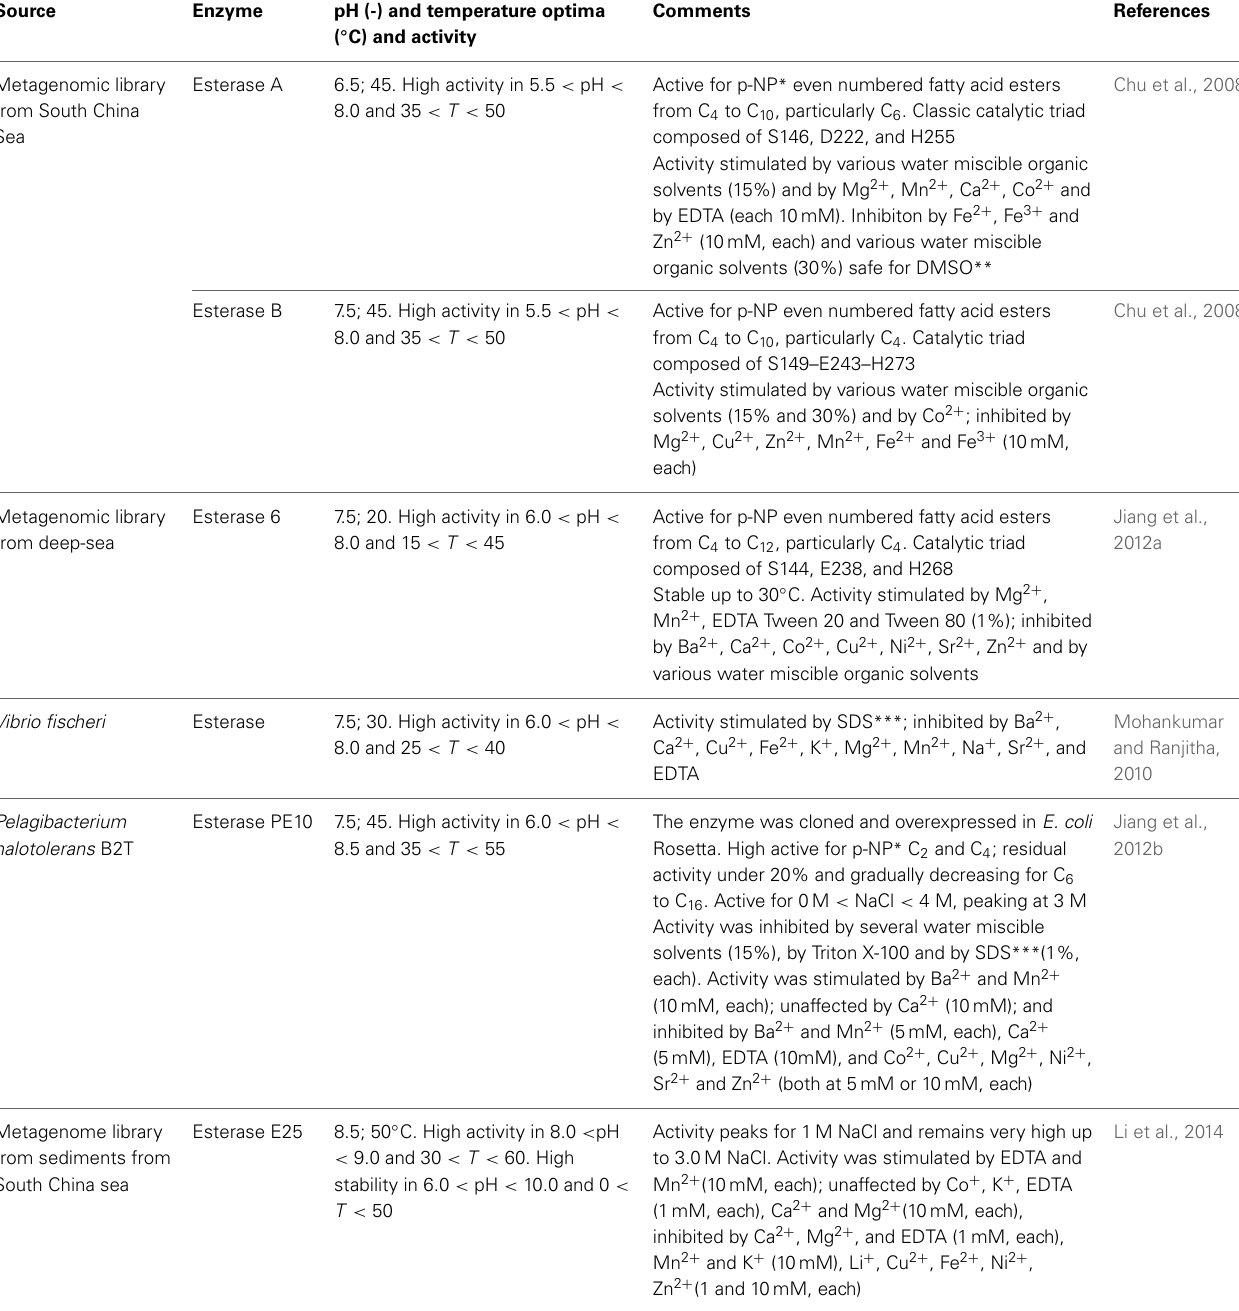
Table 6 | Some recently identified esterases from marine